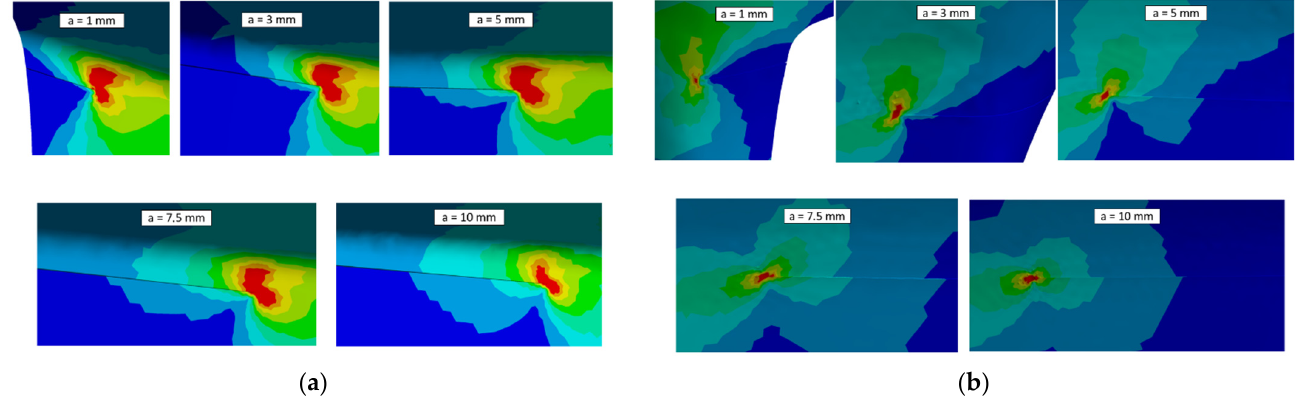
Figure 22. Equivalent von Mises stress analysis results. ( a ) Distribution of the stress around the PETE on the pressure side of the airfoil at the different crack sizes; ( b ) distribution of the stress around the PETE on the suction side of the airfoil at the different crack sizes.